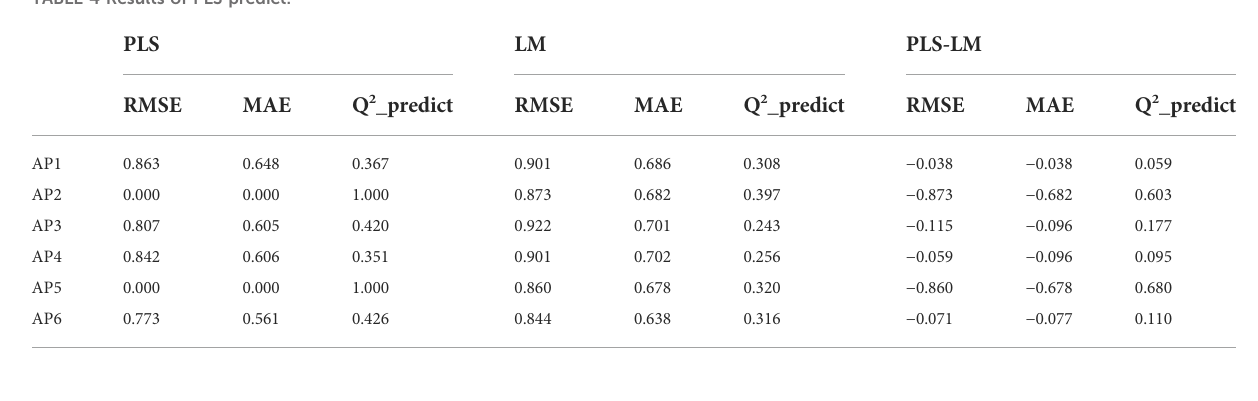
TABLE 4 Results of PLS